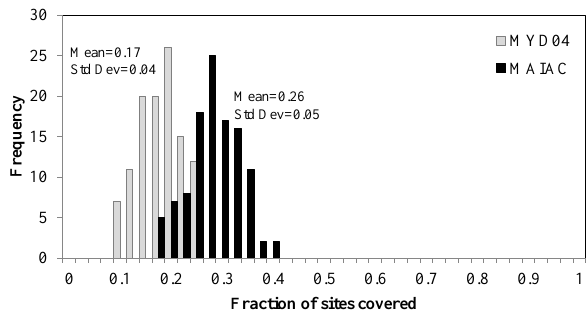
Fig. 5. Fraction of sites covered by MYD04 (grey bar) and MAIAC Figure 5. Fraction of sites covered by MYD04 (grey bar) and MAIAC (black bar) calculated as (black bar) calculated as number of observations with valid AOD number of observations with valid AOD retrievals divided by the total number of observations retrievals divided by the total number of observations for each of EPA site ( N = 85). for each of EPA site (N=85).